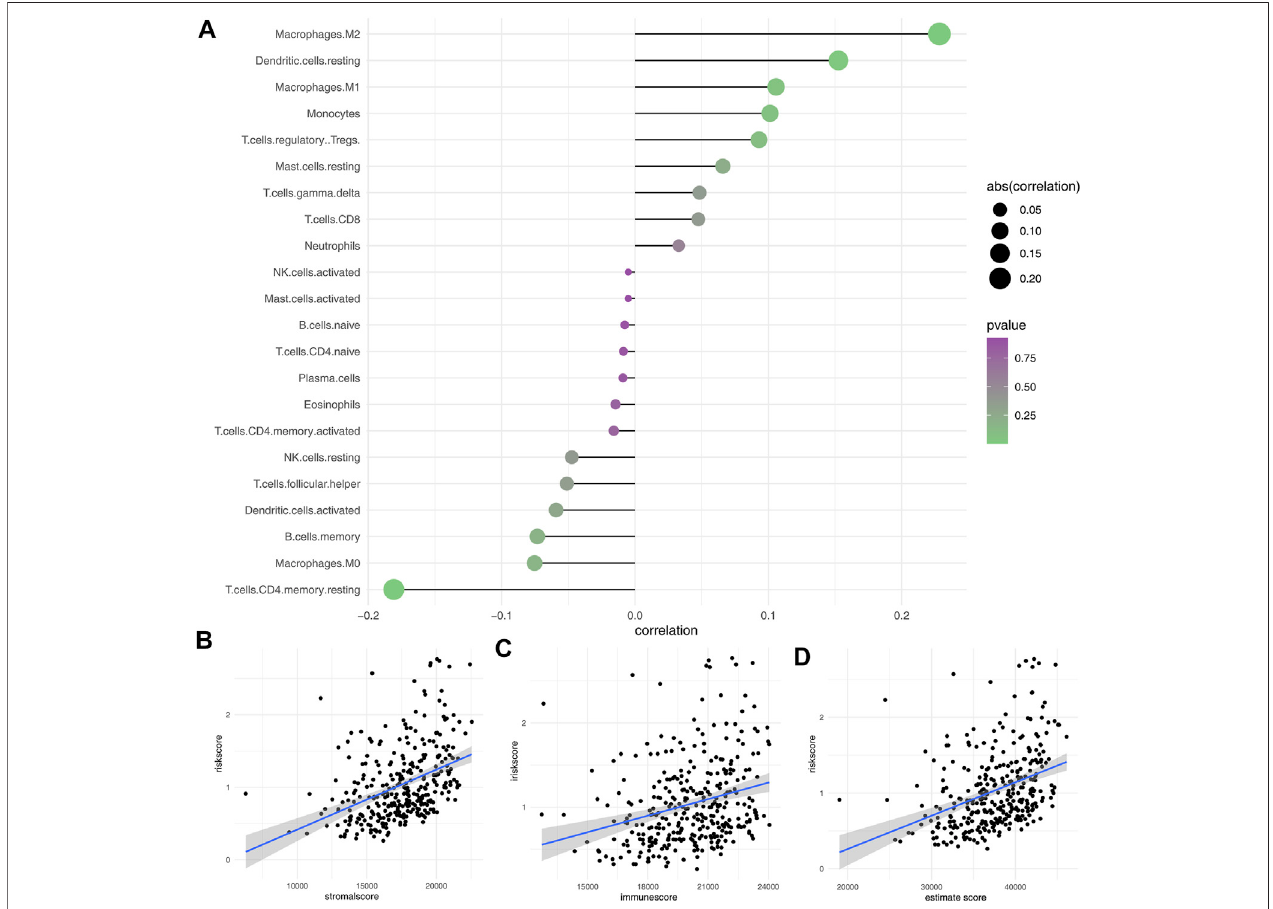
FIGURE7| Immunein fi ltrationanalysis. (A) :CIBERSORTalgorithmwasusedtoevaluatetherelativeproportionsof22immunein fi ltratingcellsinlow-andhigh-risk groups; (B – D) : Correlation between risk score and immune score, stromal score, and estimate score.